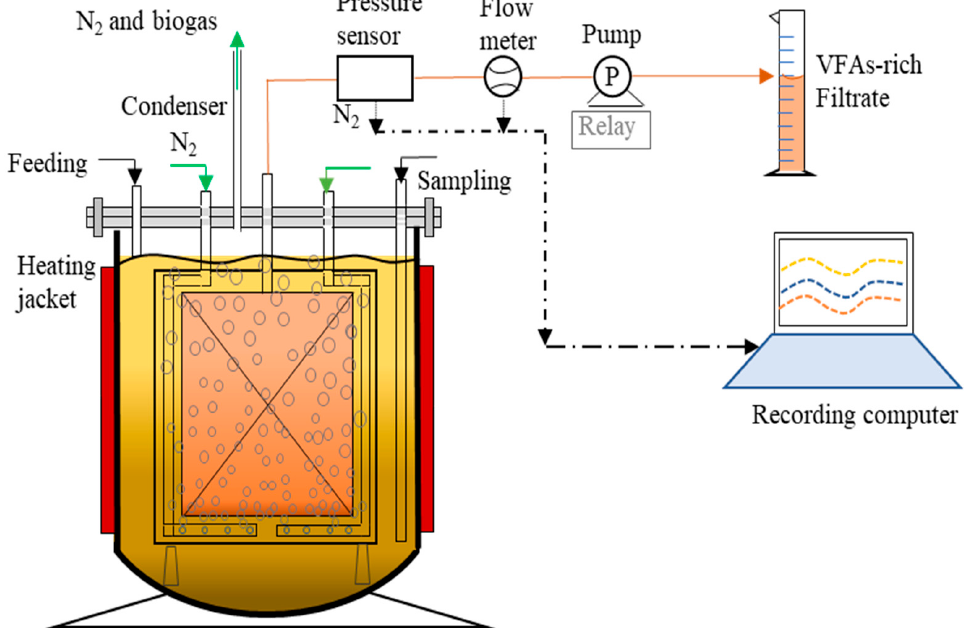
Figure 1. Schematic diagram of the applied Anaerobic Membrane bioreactor (AnMBR). Initially, 3.5 L of inoculum (heat-shocked CM, VS of 100 g/L) was filled into AnMBR1 and AnMBR2, separately, followed by pH adjustment to 6 for AnMBR1. During the startup phase (days 0–7), reactors were operated in batch mode until the VFA in the inoculum were consumed, reaching a stable level (2.3 g/L). After the startup phase, AnMBRs were shifted to semi-continuous mode with initial feeding of 20 g-VS/L from day 8 to 53 (OLR of 2 g-VS/(L · d)), followed by a period of OLR 4 g-VS/(L · d) from day 54 to 78 (feeding VS of 40 g-VS/L). For AnMBR2, pH was recorded once per day prior to feeding. 15 mL of well mixed effluent was sampled every day for the analysis of medium characteristics, such as viscosity, TS, VS, TSS, VSS, TCOD, and SCOD. Permeate containing VFA was filtered out (335 mL) on daily basis followed by feeding (350 mL) pretreated CM. The filtration process consisted of a 6 min filtration cycle (flow rate of 20 mL/min) followed by a 30 s backwash cycle (flow rate of 60 mL/min) for physical membrane cleaning. The concentration of VFA and ammonium nitrogen (NH 4+ -N) in the permeate was analyzed every day. To remediate filtration related issues, SS draining was applied at different time